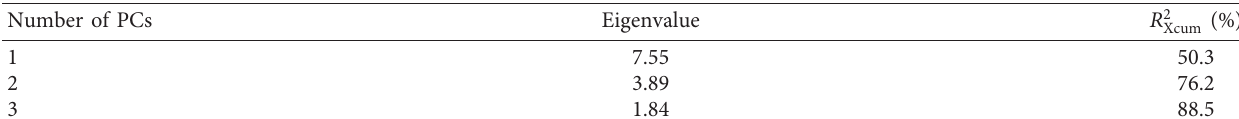
Figure 4: Colour measurement of different species (a) and differently prepared slices (b) of Zedoray Rhizome. • Compared with CW, p < 0 . 05; # compared with CP, p < 0 . 05; ∗ compared with CR, p < 0 . 05. Table 3: Diagnostics of the PCA model for different species of Zedoray Rhizome samples.